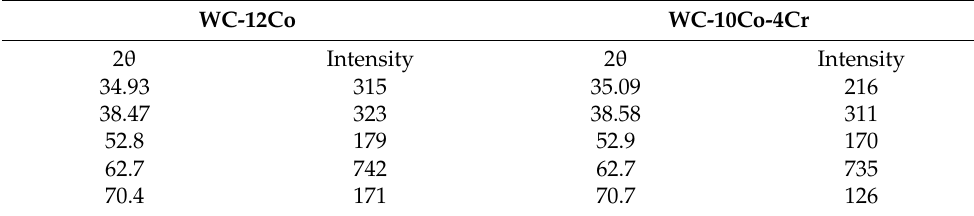
Table 3. Comparison between W 2 C peak parameters of WC-12Co and WC-10Co-4Cr